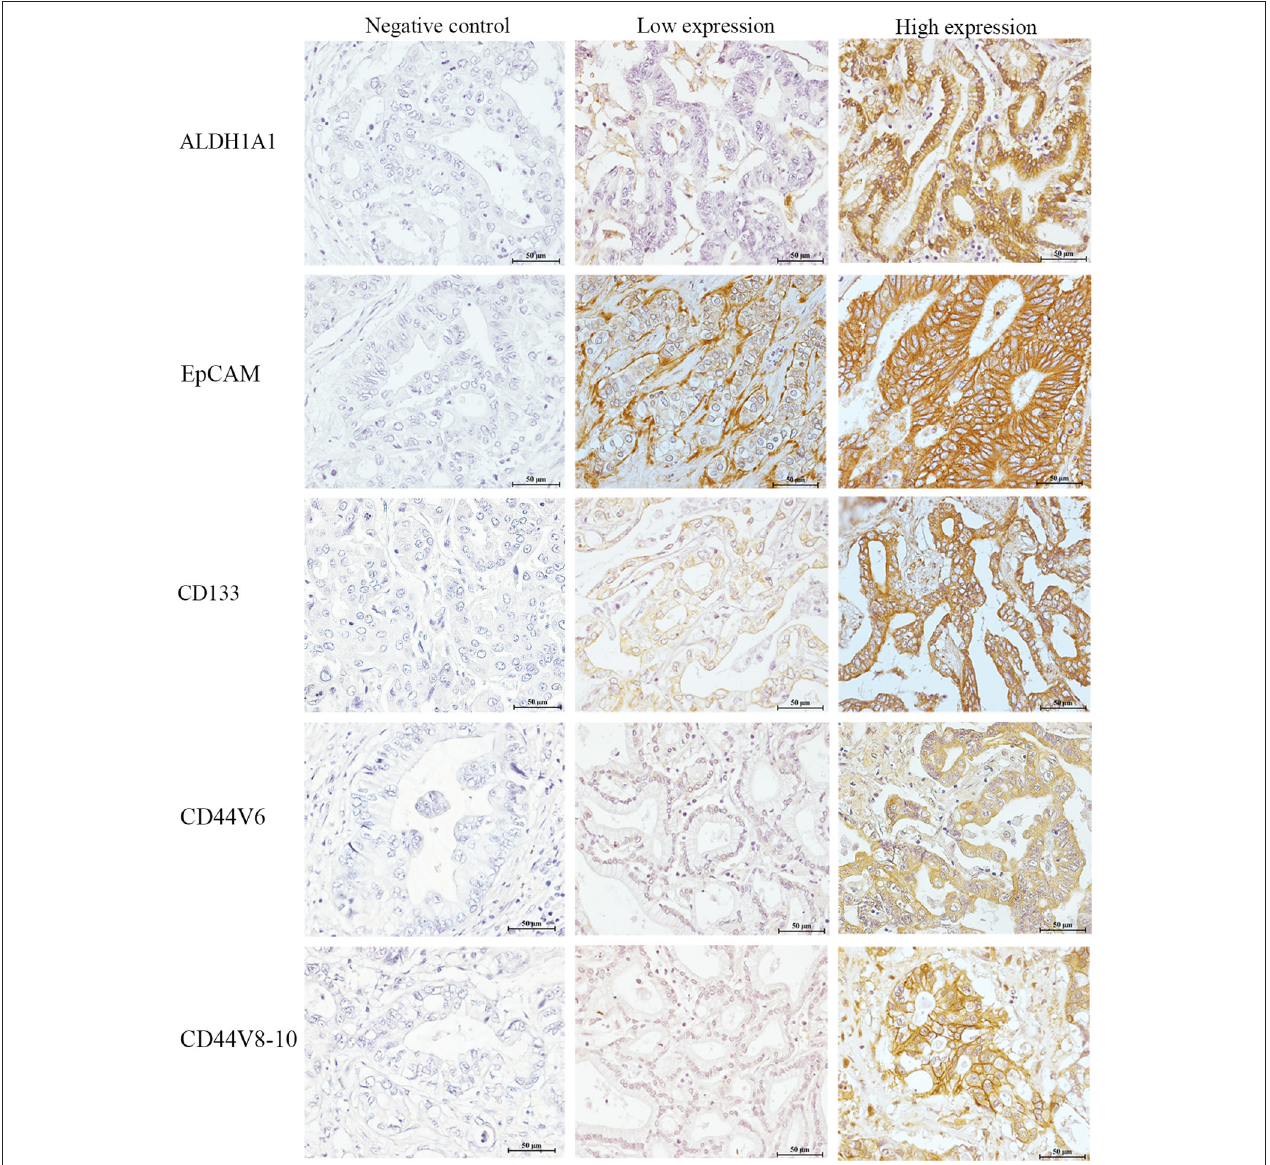
FIGURE 4 | The expression of cancer stem cell (CSC) markers in human CCA tissues. The left panel represents the negative control. The middle panel represents low expression of each CSC marker. The right panel represents high expression of each CSC marker. Bar 50 µ m